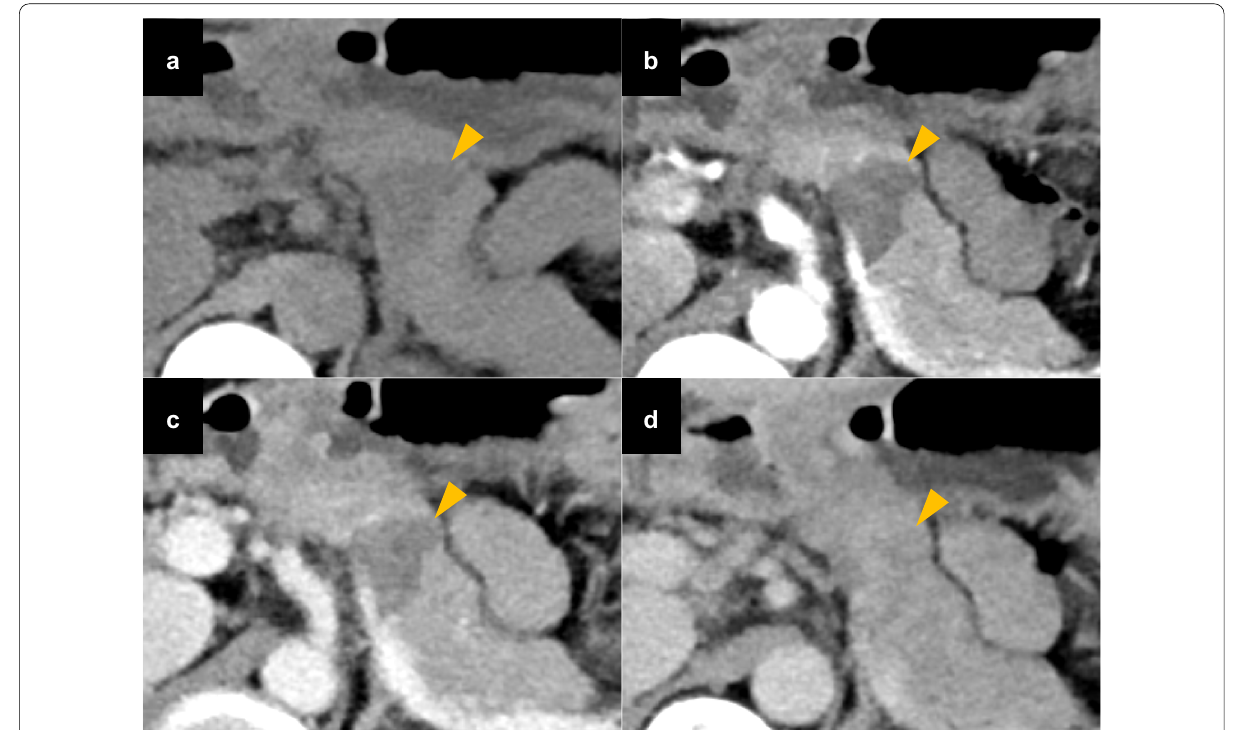
Fig. 1 Contrast-enhanced computed tomography showing a gradually enhanced tumor (triangles) at the pancreatic body and tail. a Plain. b Arterial phase. c Portal phase. d Delayed